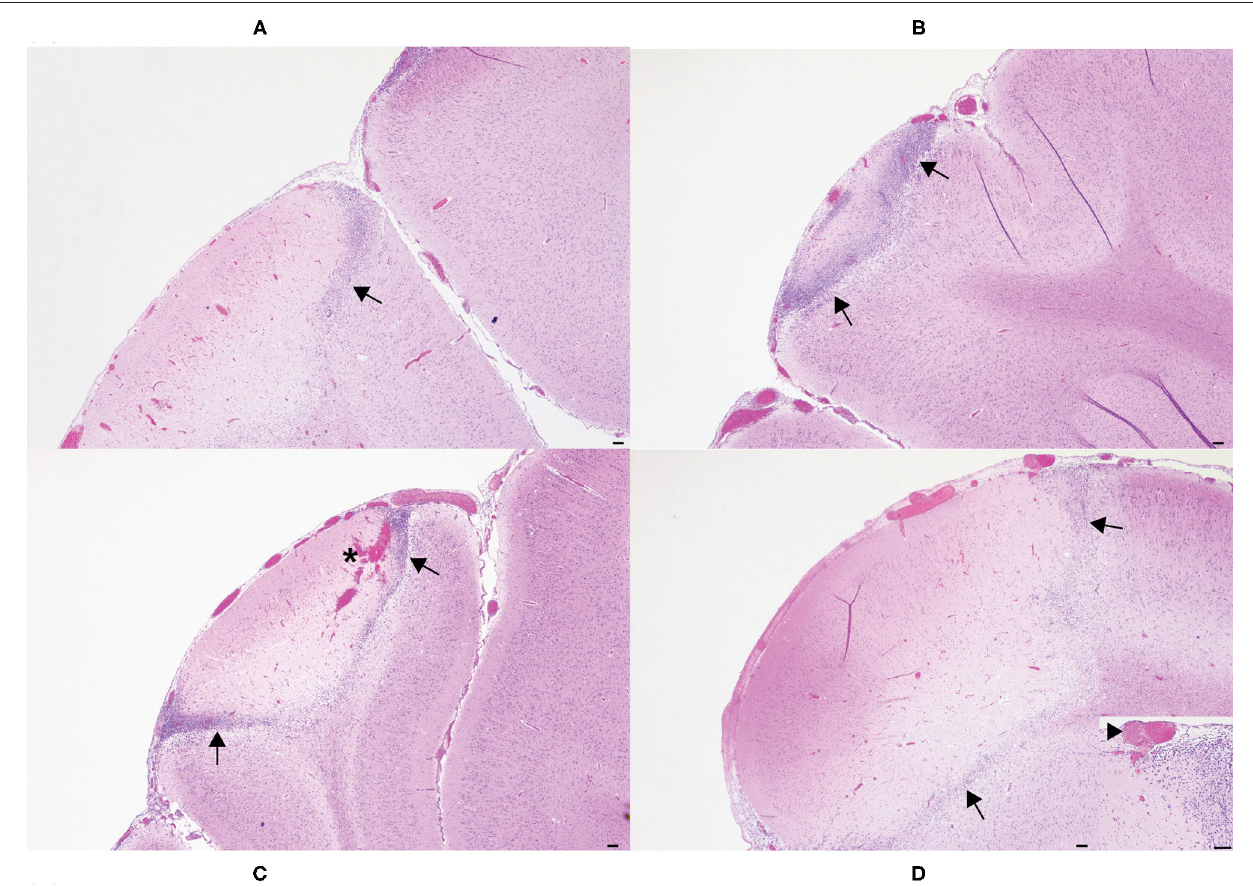
FIGURE 4 | Histologic images of affected cerebral gyri from the 5s (A) , 10s (B) , 15s (C) , and 20s (D) applications. In all application times, the cerebrum subjacent to the horn bud contained areas of leptomeningeal and cortical necrosis, often rimmed by moderate to large numbers of gitter cells (arrows). Hemorrhage was also present in the 15s application ( C , asterisk). Occlusive thrombi were identified within leptomeningeal blood vessels of most applications, but most frequently in the 20s application ( D , inset, arrowhead). Hematoxylin and eosin. Scale bars = 100